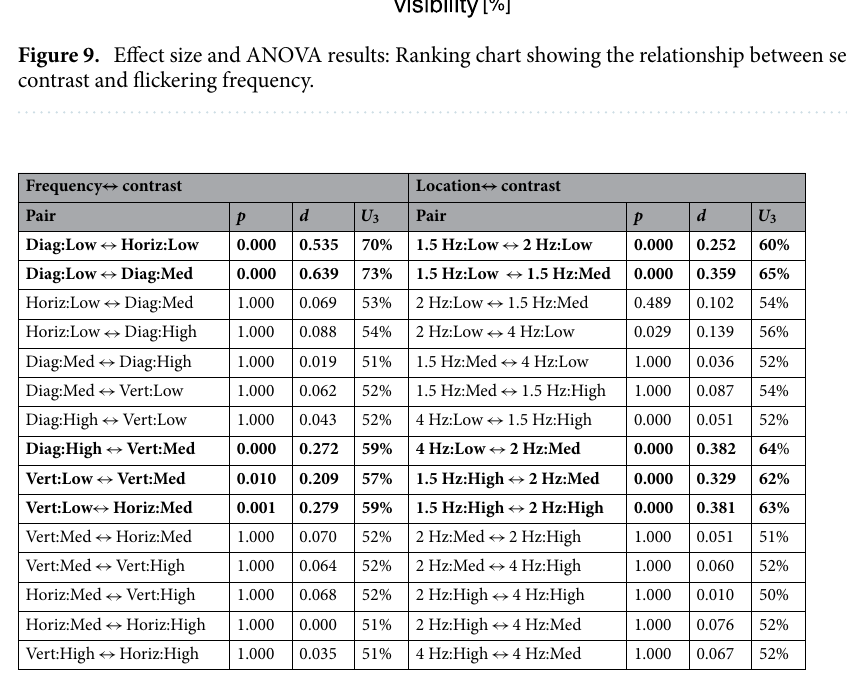
Table 2. P values of the t test between pair of conditions (without compensation for multiple comparisons) and d -Cohen, U 3 -Cohen of ES for (location respectively. Statistical significant results (for t test and ES both) are in bold.